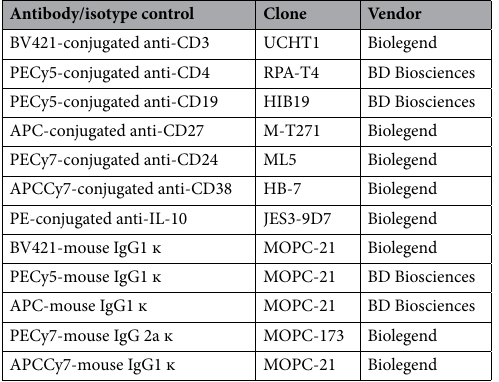
Table 2. Fluorescent-labeled antibodies and isotype controls used for flow cytometry